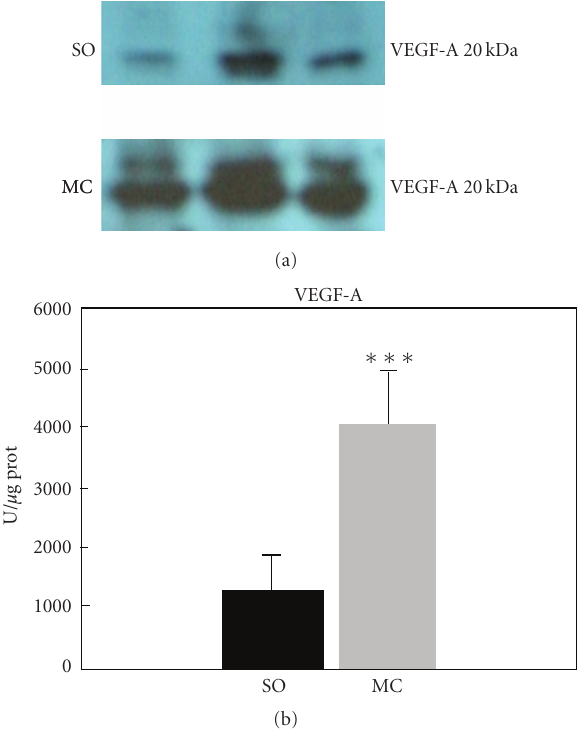
Figure 7: Increased intestinal levels of Vascular Endothelial Growth Factor (VEGF)-A in sham-operated (SO) and microsurgical micro- surgical obstructive cholestatic rats (MC). The VEGF-A expression was assayed by Western blot and quantified by optical densitometry (O.D). ∗∗∗ P < . 001: statistically significant value in relation with